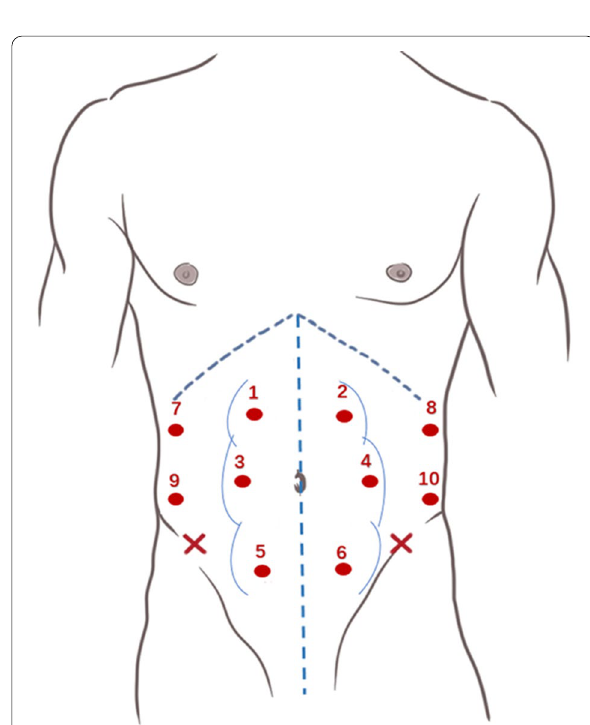
Fig. 3 Ten specific locations for shear wave elastography